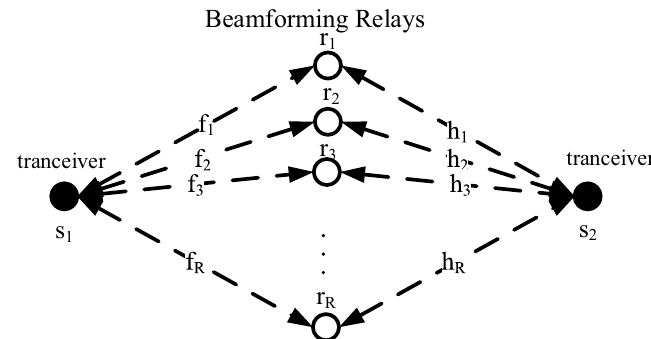
Fig. 1 The EH relaying beamforming system. It is our system structure